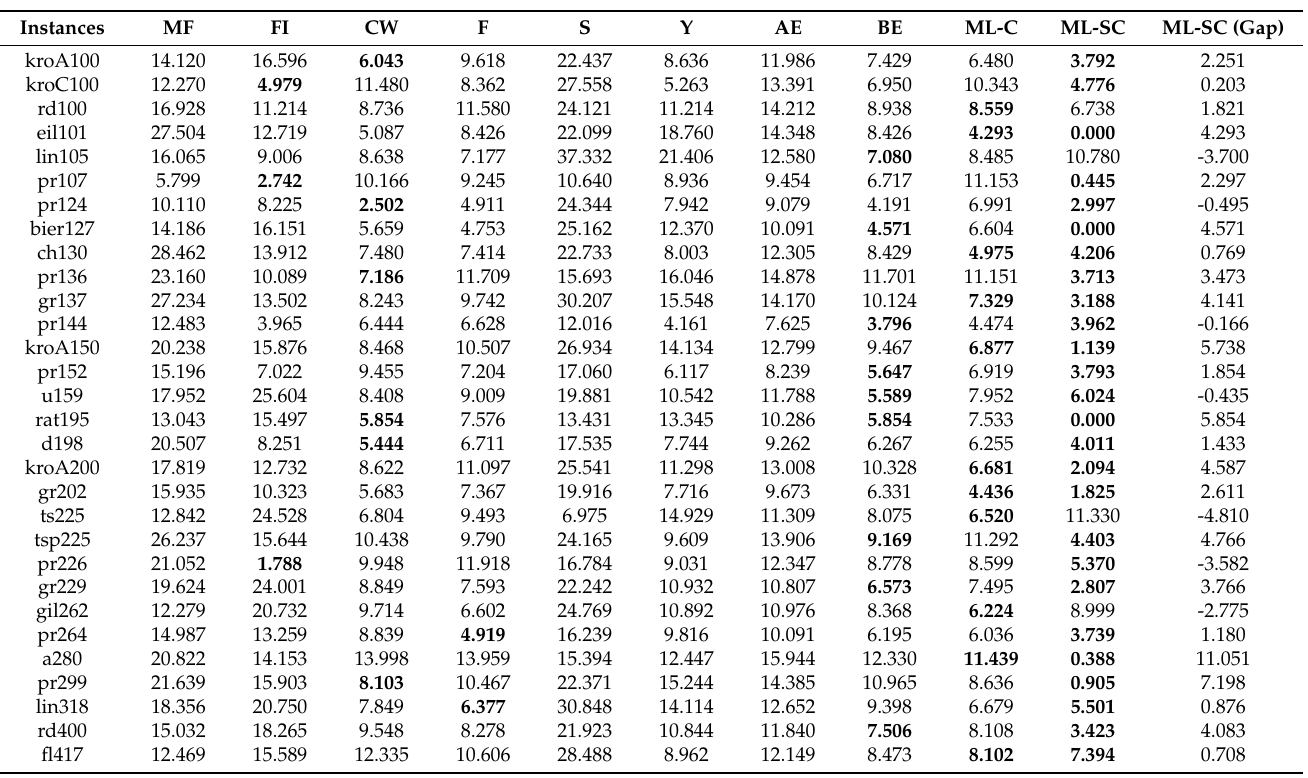
Table 3. Percentage error comparison of various decision-takers policies for testing TSPLIB instances.